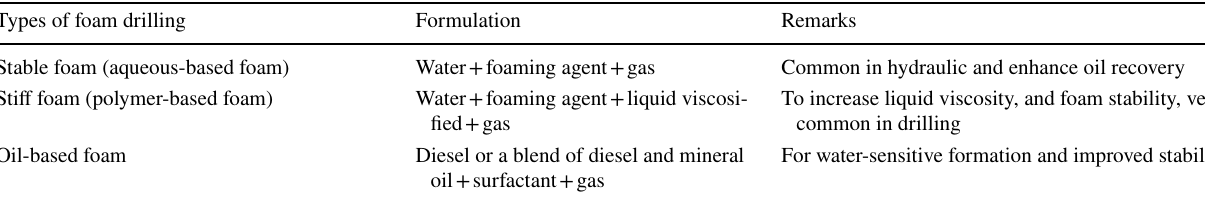
Table 8 Types of foam drilling